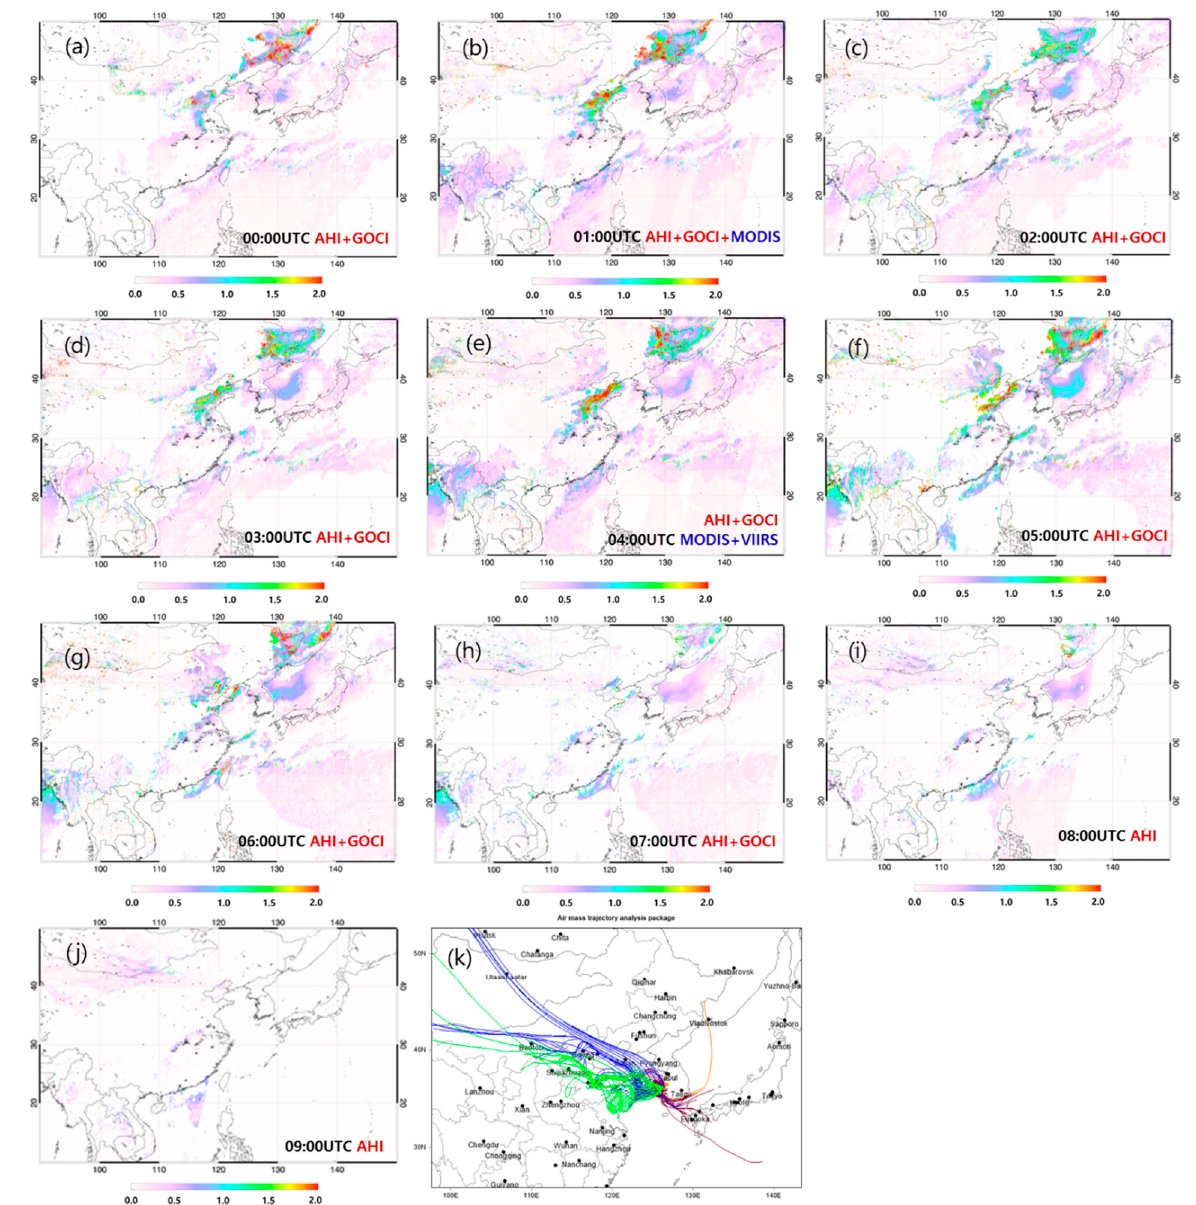
Figure 7. Hourly composites of AOD from 00:00–09:00 UTC on 5 May 2017, and a three day back trajectory of the HYSPLIT Model: ( a ) 00:00 UTC, ( b ) 01:00 UTC, ( c ) 02:00 UTC, ( d ) 03:00 UTC, ( e ) 04:00 UTC, ( f ) 05:00 UTC, ( g ) 06:00 UTC, ( h ) 07:00 UTC, ( i ) 08:00 UTC, ( j ) 09:00 UTC, and ( k ) HYSPLIT on 3 (orange), 4 (purple), 5 (blue), and 6 (light green), May.